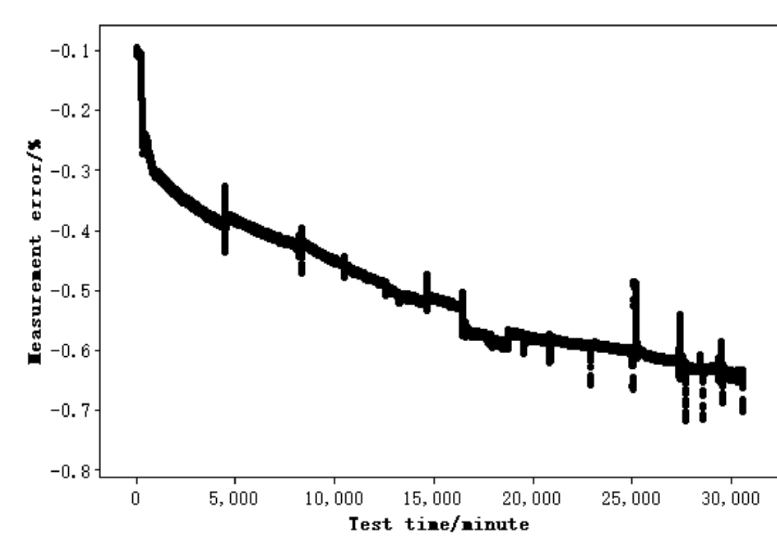
Figure 4. Cumulative increase of measurement error.